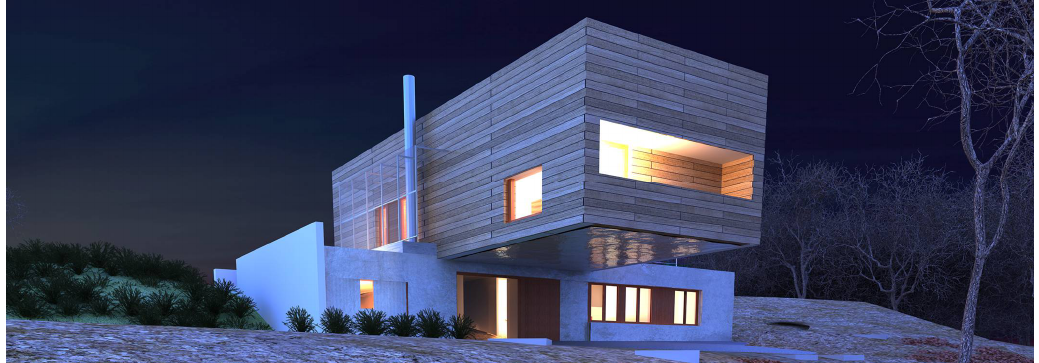
Figure 10. 3D Modeling and rendering. Bioclimatic house by architect Carlo Barbieri, Santorso Italia (student Stefano Di